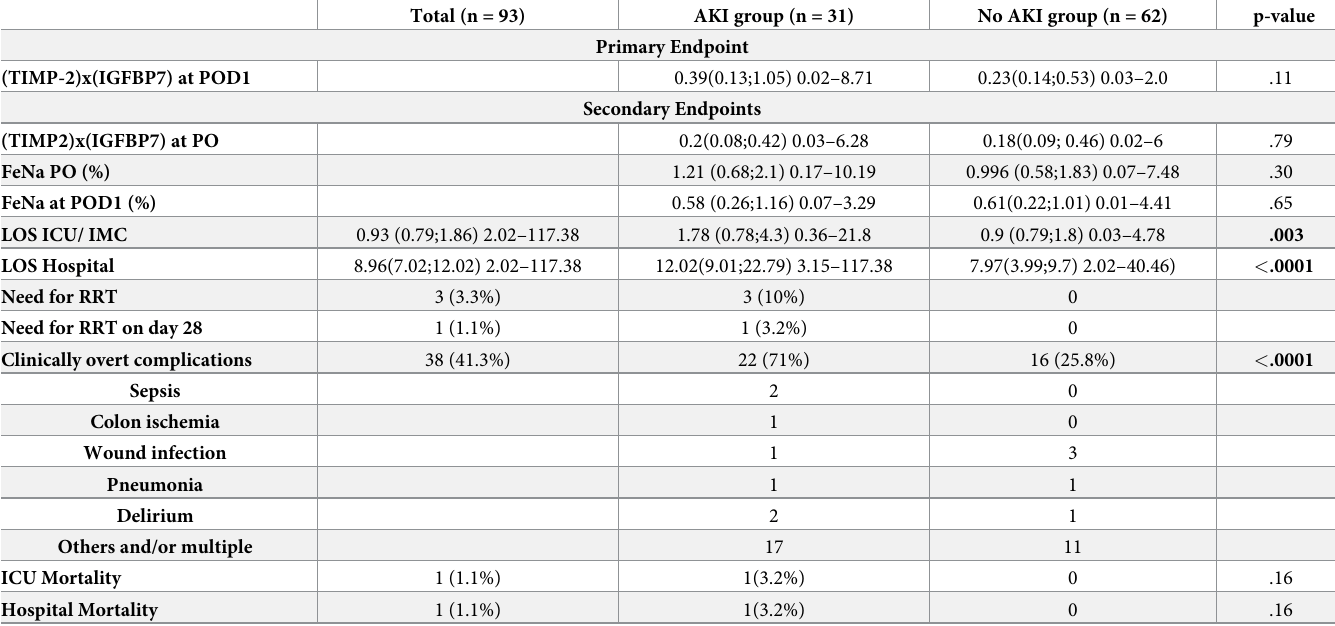
Table 3. Primary and secondary endpoints in AKI vs. non-AKI groups.